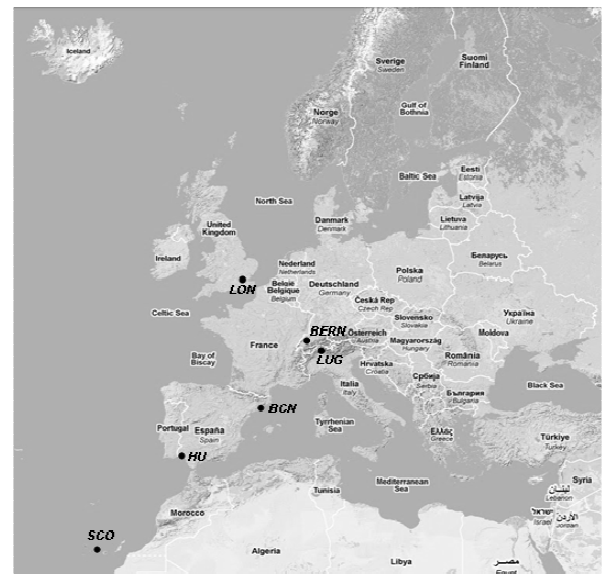
Fig. 1. Location of the six cities selected in the present study.